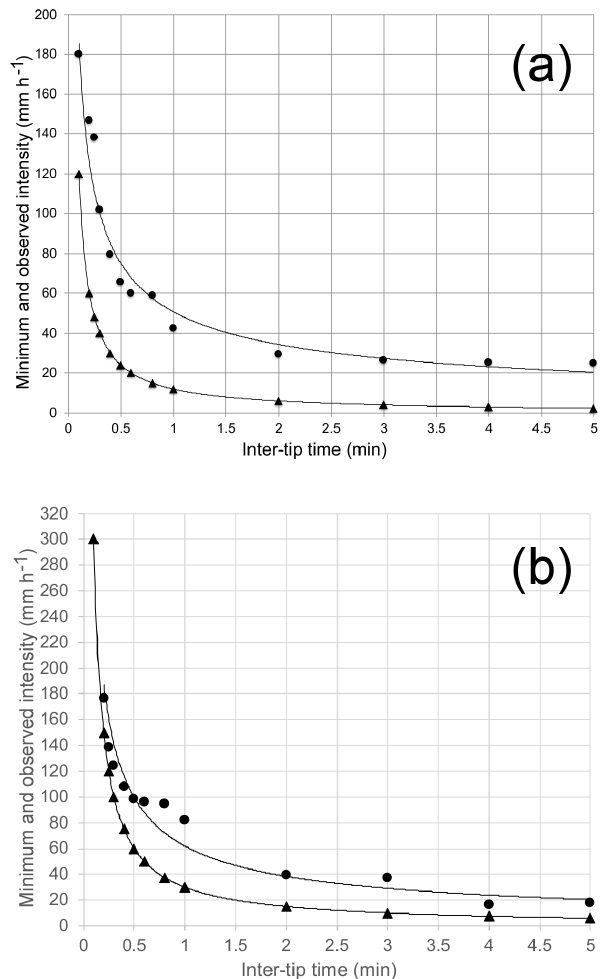
Figure 4. Expected intensity of intensity bursts of fixed ITTs hav- ing varying durations from 0.1 to 5min (solid triangle symbols) and observed intensity of longest run of ITTs not exceeding each ITT (solid circle symbols). Locations: MM (a) and FG (b) . Fitted re- gression relations are shown by solid lines (for equations, see text). Note that in all cases, the observed intensities exceed those expected from fixed ITTs, indicating that the rainfall included some ITTs that were of shorter duration than the ITT indicated on the x